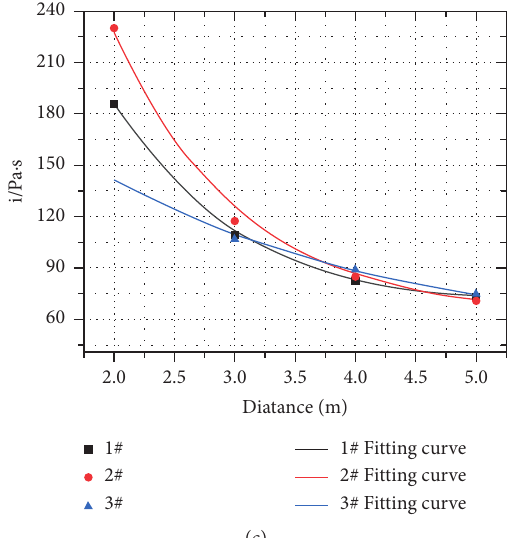
Figure 12: Measurement results of shock wave overpressure, positive pressure acting time, and specific